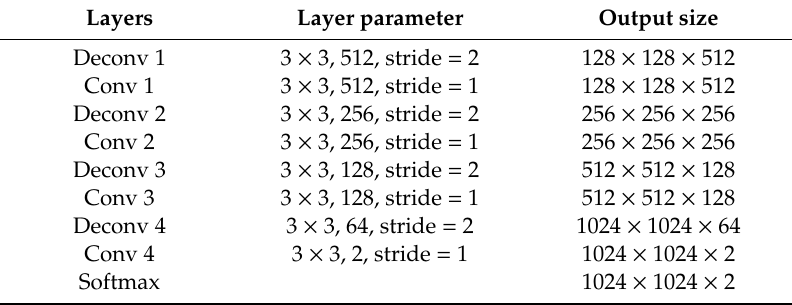
Table 2. Configuration of the scene mask extraction